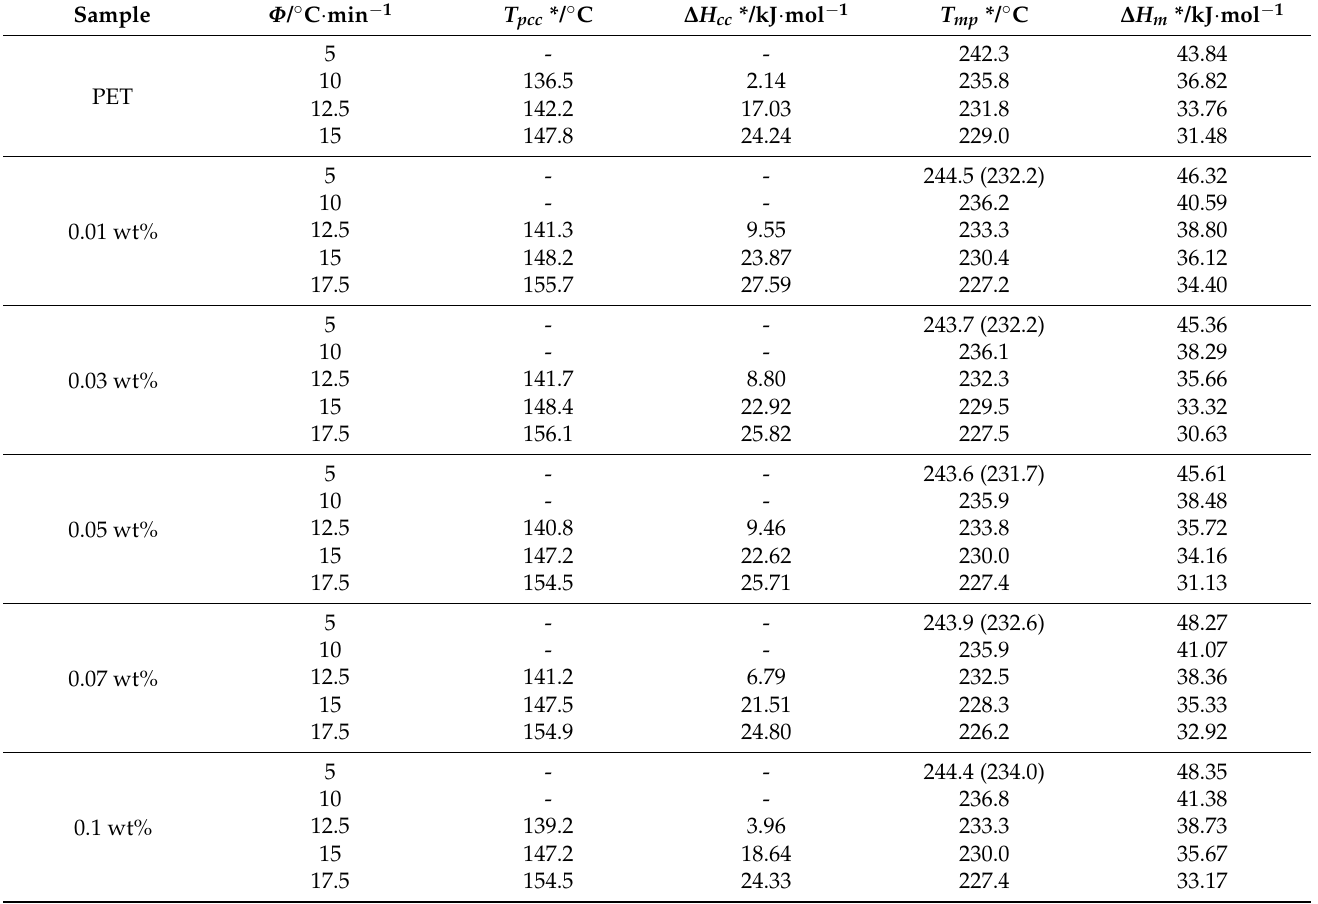
Table 2. Value of heating curves after non-isothermal